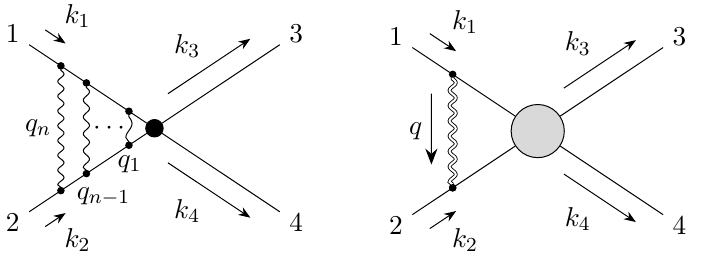
Figure 1. Left panel: the leading Sudakov diagrams topology. Right panel: a diagrammatic representation of the contributions to the amplitude variation that are logarithmically enhanced. The momentum q is integrated over the infinitesimal strip δσ